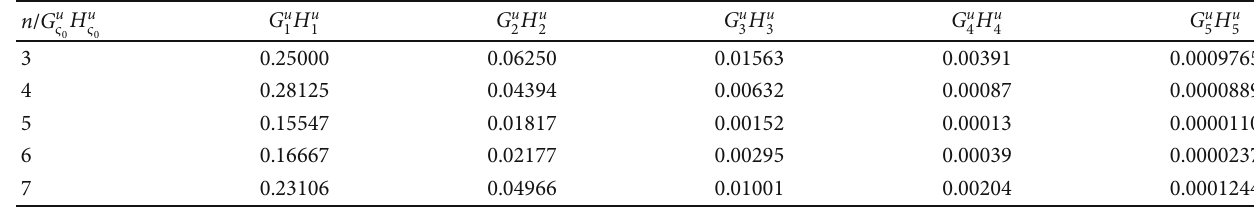
Table 1: Associated constants of Doo-Sabin subdivision scheme for distinct valence numbers.